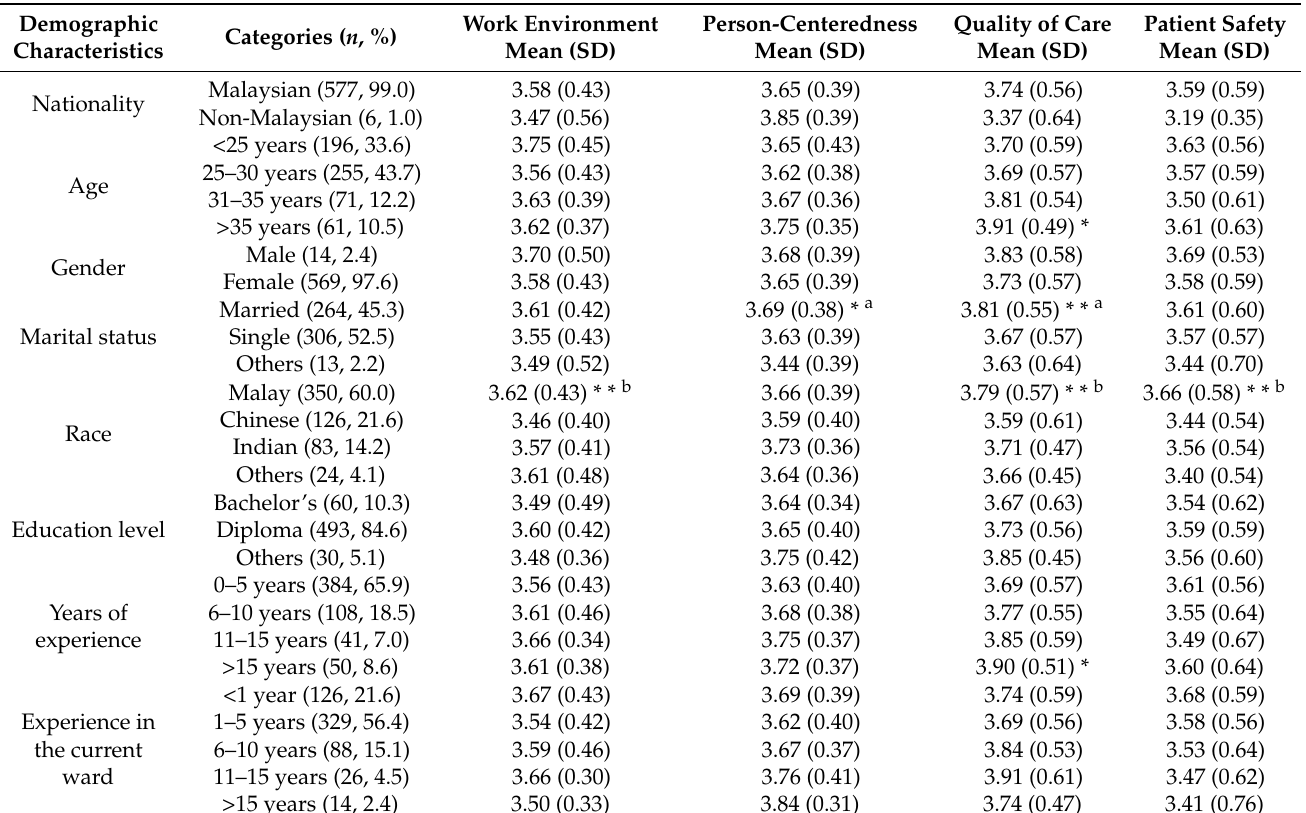
Table 1. Nurses’ Demographic Data and Differences between Nurses in the Perceived Practice Environment, Person- centeredness, Quality, and Patient Safety.